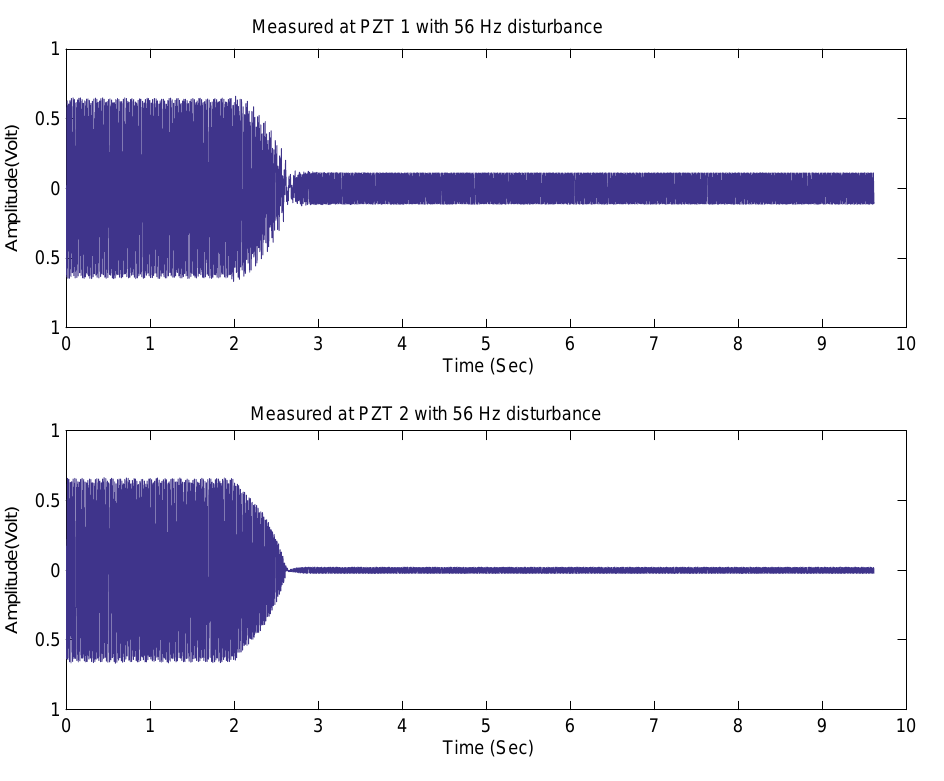
Fig. 11. Vibration suppression with 56 Hz sinusoidal disturbance using sliding mode